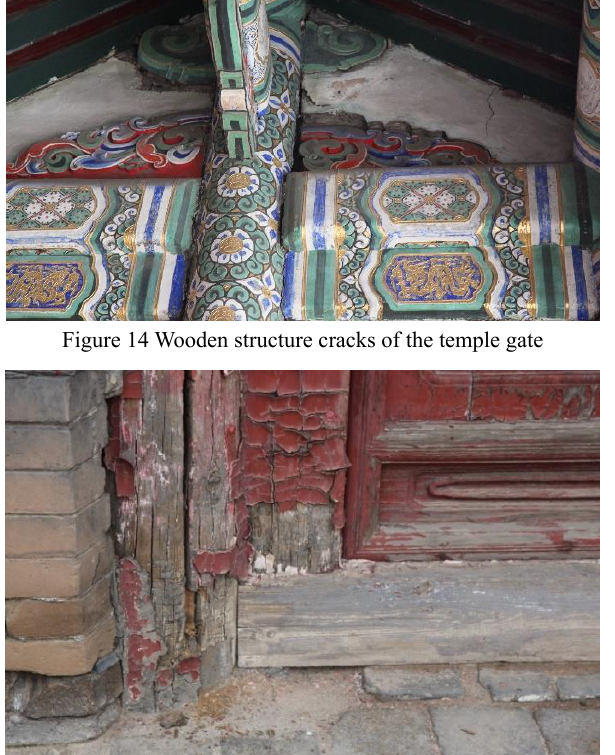
Figure 16 wall cracks of the temple gate in the